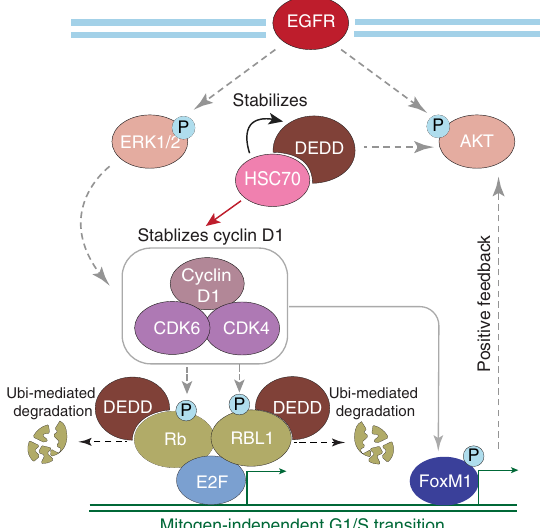
Fig. 7 Proposed model of the roles of death effector domain-containing DNA-binding protein ( DEDD ) and combinatorial treatment mechanism in triple-negative breast cancer (TNBC). Proposed model of the roles of DEDD in TNBC and the combinatory therapy mechanism in DEDD -ampli fi ed